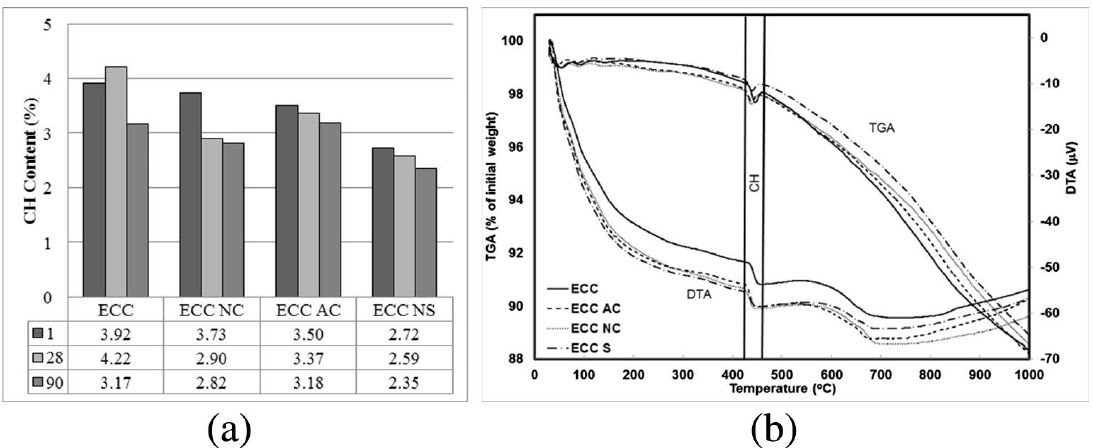
Figure 9. ( a ) Change of Ca(OH) 2 content of engineered cementitious composite (ECC) mixtures with age. ( b ) Typical series of thermogravimetric analysis (TGA/DTA) curves of mixtures at the age of 28 days [78].